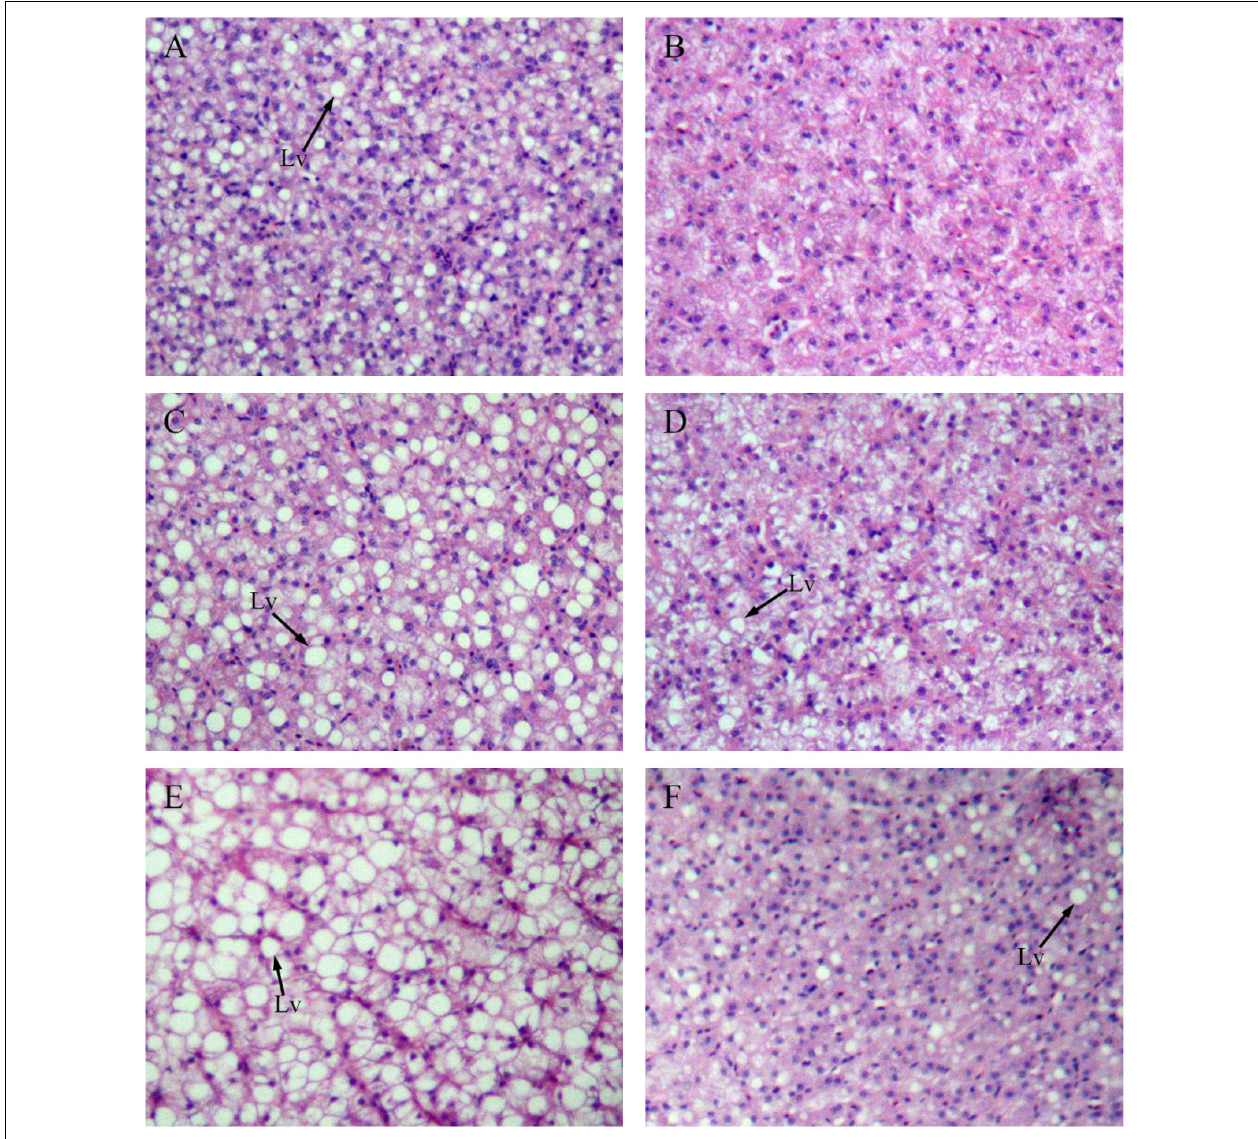
FIGURE 4 | Hematoxylin-eosin staining of liver tissues of GIFT fed experimental diets on day 20, 40, and 60. Magnification 200 × . (A) Fish fed high-fat diet (HFD, 18.5% lipid level) for 20 days; (B) fish fed-normal fat diet (NFD, 8% lipid level) for 20 days; (C) fish fed HFD for 40 days; (D) fish fed NFD for 40 days; (E) fish fed HFD for 60 days; (F) fish fed NFD for 60 days. Lv, lipid vacuole.